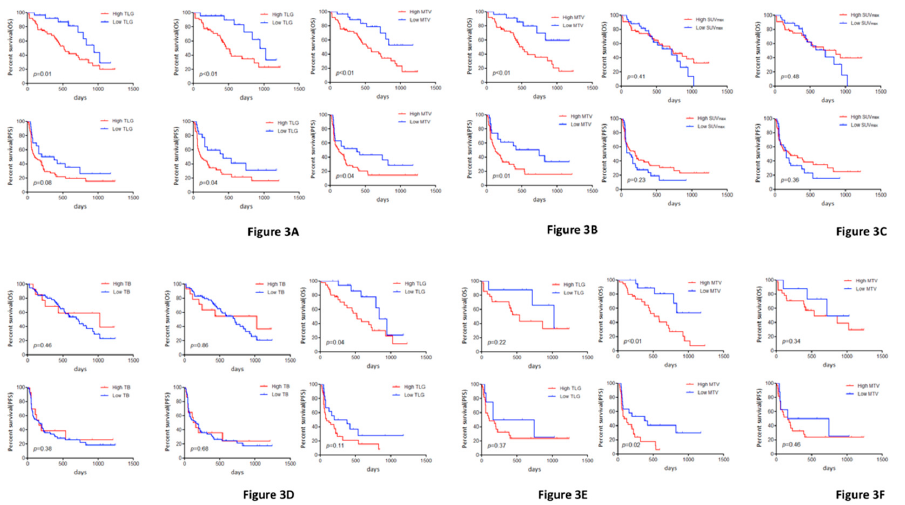
Figure 3. Kaplan–Meier curves according to various TLG ( A ), MTV ( B ), SUVmax ( C ) and TB ( D ) for OS and PFS. ( A ); OS (upper left) and PFS (lower left) in all patients and OS (upper right) and PFS (lower right) in those without EGFR mutation according to TLG. ( B ); OS (upper left) and PFS (lower left) in all patients and OS (upper right) and PFS (lower right) in those without EGFR mutation according to MTV. ( C ); OS (upper left) and PFS (lower left) in all patients and OS (upper right) and PFS (lower right) in those without EGFR mutation according to SUVmax. ( D ); OS (upper left) and PFS (lower left) in all patients and OS (upper right) and PFS (lower right) in those without EGFR mutation according to TB. ( E ); OS (upper left) and PFS (lower left) in patients with AC patients and OS (upper right) and PFS (lower right) in those with non-AC according to TLG. ( F ); OS (upper left) and PFS (lower left) in patients with non-AC patients and OS (upper right) and PFS (lower right) in those with non-AC according to MTV. Abbreviation: TLG, total lesion glycolysis; MTV, metabolic tumor volume; SUVmax: maximal standardized under value; TB, tumor burden; OS, overall survival; PFS, progression-free survival; AC, adenocarcinoma; non-AC,